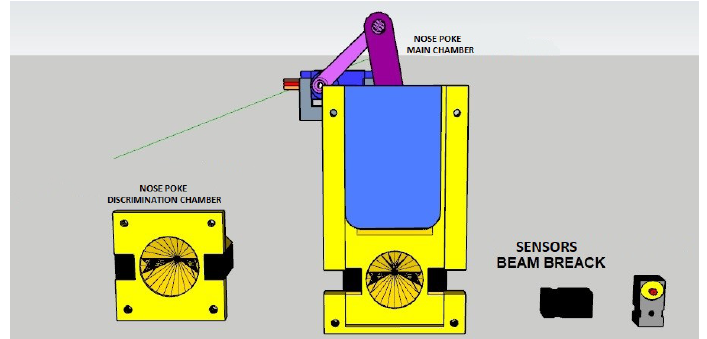
Figure 12. Nose poke front